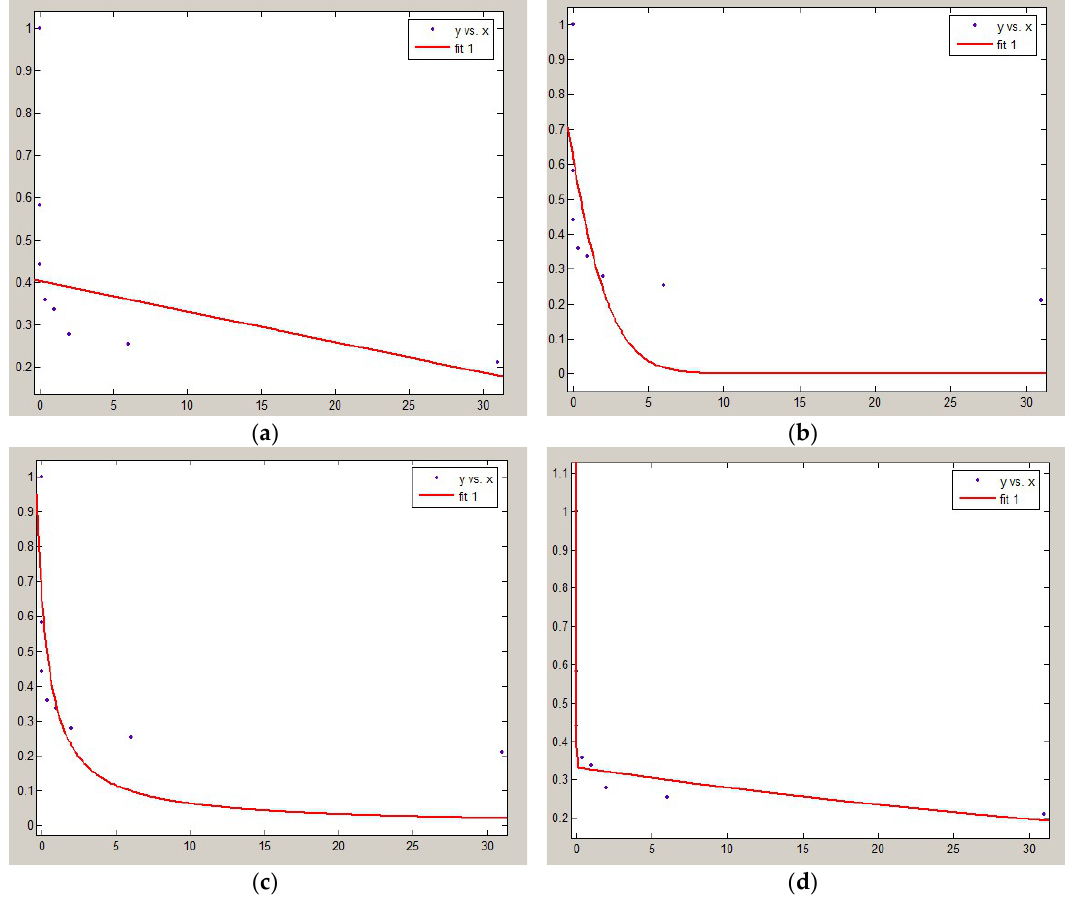
Figure 3. Fitting curves of different functions. They are listed as: ( a ) Linear function; ( b ) Gaussian function; ( c ) Rational function; ( d ) Exponential function.